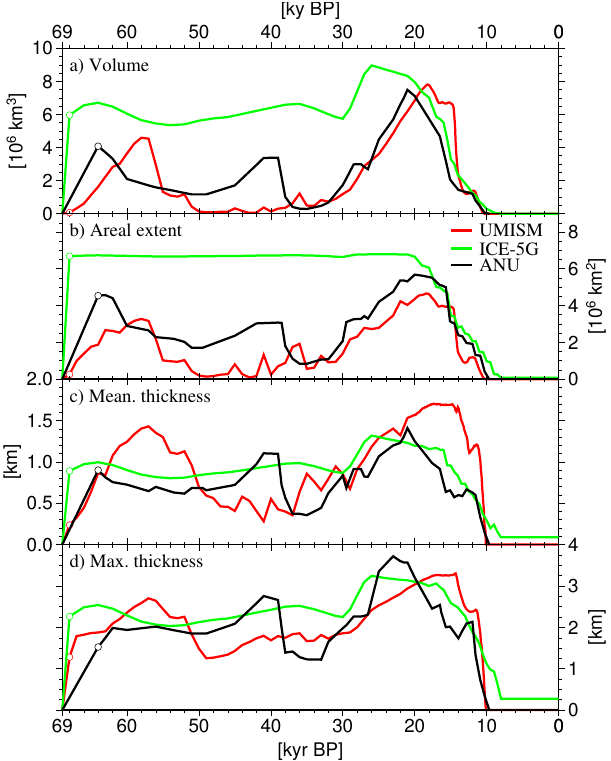
Figure 2. Temporal development of (a) ice volume, (b) areal ex- tent, (c) mean thickness and (d) maximum thickness of the UMISM (red), ICE-5G (green) and ANU (black) ice sheet reconstructions as implemented in this study. The simulations are started by linearly increasing the load from 0 at 69 kyr BP to the snapshot of each re- construction closest in time as shown by the unfilled circles in the figure. The non-zero thickness in ICE-5G from about 8kyrBP un- til today is associated with a non-vanishing small ice cover in the northernmost part of Nova Zemlya,